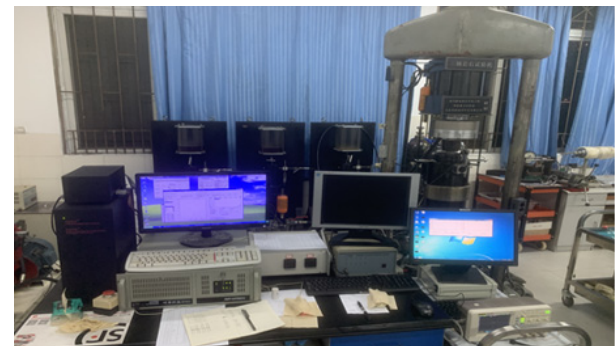
Figure 3. Triaxial mechanical testing